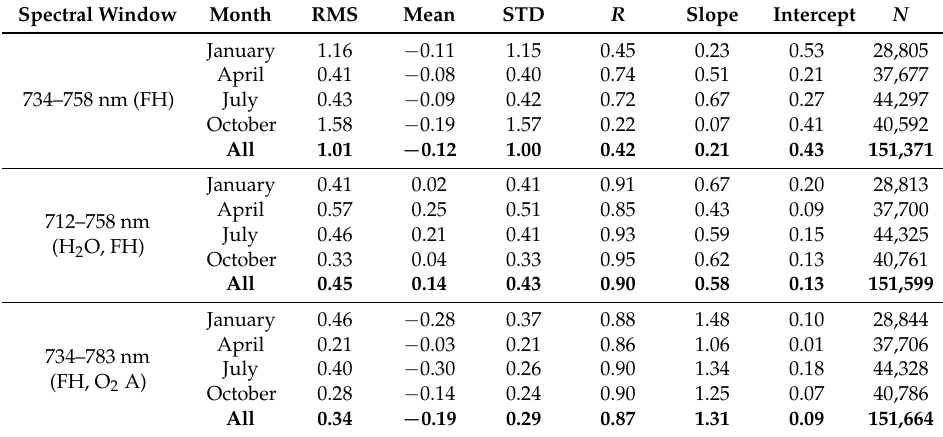
Table 4. Similar to Table 3 but for tests with different fit windows. Spectral windows 734–758 nm, 712–758 nm or 734–783 nm are compared to 712–783 nm (baseline). The windows contain Fraunhofer lines (FH), water vapour and/or oxygen absorption, as indicated in the table. All correlations are highly